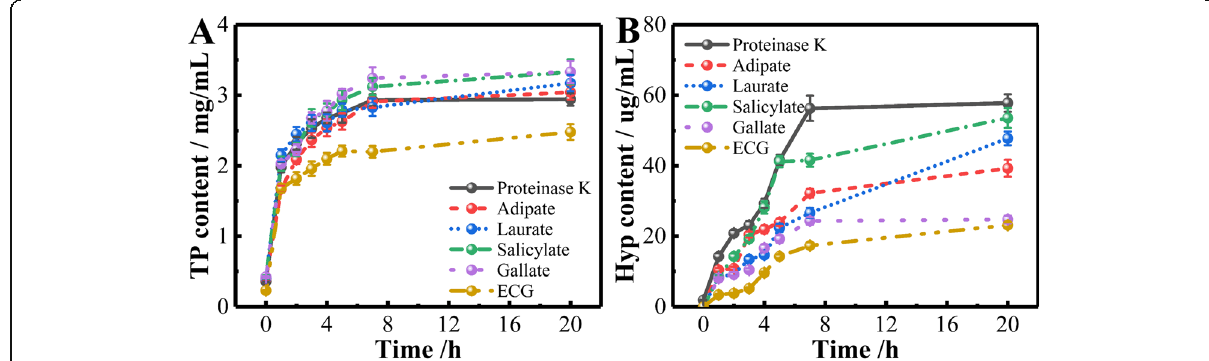
Fig. 4 Hyp and Total protein content in the float during enzymatic unhairing by adding organic